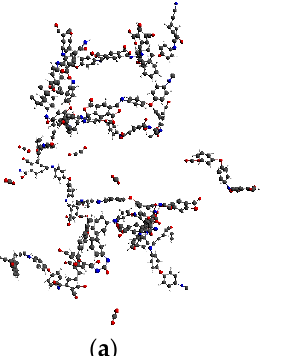
Figure 4. Pyrolysis results at 2200 K. ( a ) PI neat; ( b ) PI/BNNS.